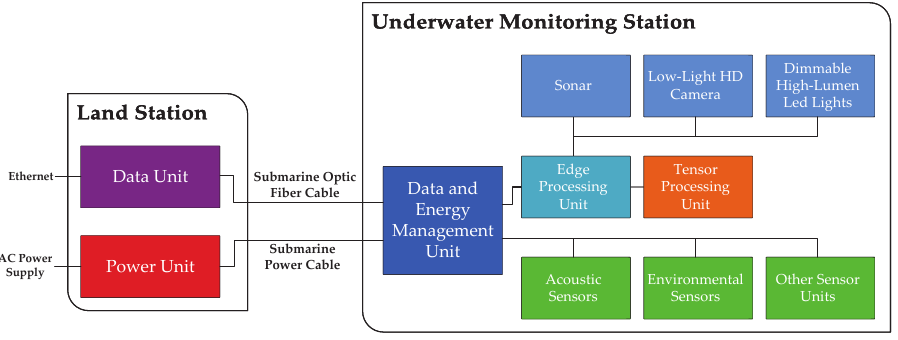
Figure 1. Diagram presenting the overall structure of the underwater monitoring station prototype, with the underwater monitoring station connected to the land station by submarine optic fiber and power